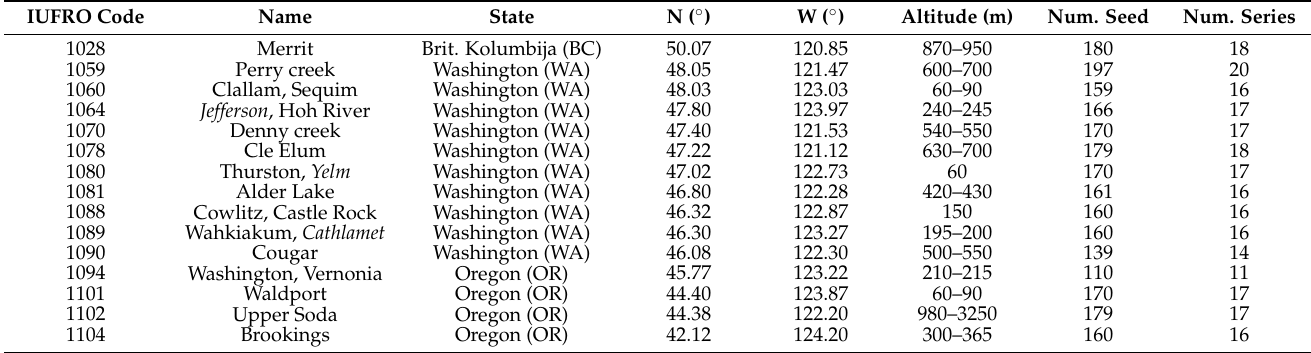
Table 1. Provenances in Padež I trial plot: IUFRO code—international provenance IUFRO code; name—provenance name (nearby city); state—federal state; N ( ◦ ) and W ( ◦ )—geographical coordinates; altitude (m)—altitude in meters above sea level; num. seed—total number of planted seedlings per provenance; num. series—number of repetitions [24,27,36]. IUFRO